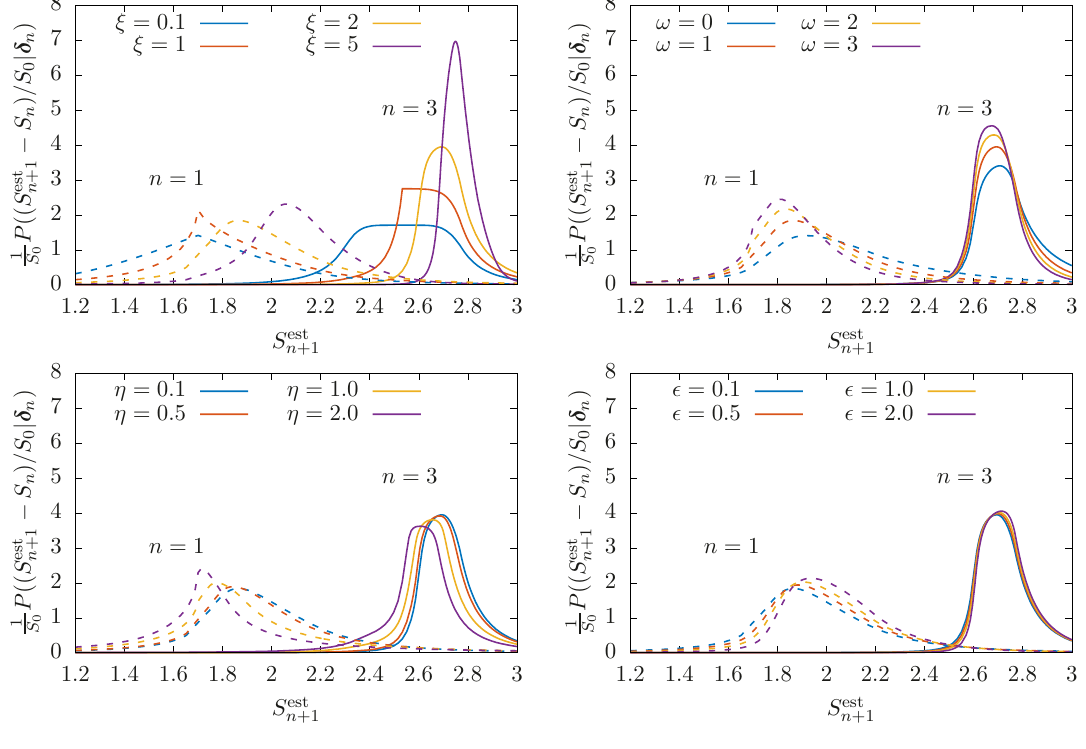
− S n ) /S 0 | δ n ) for geo- n +1